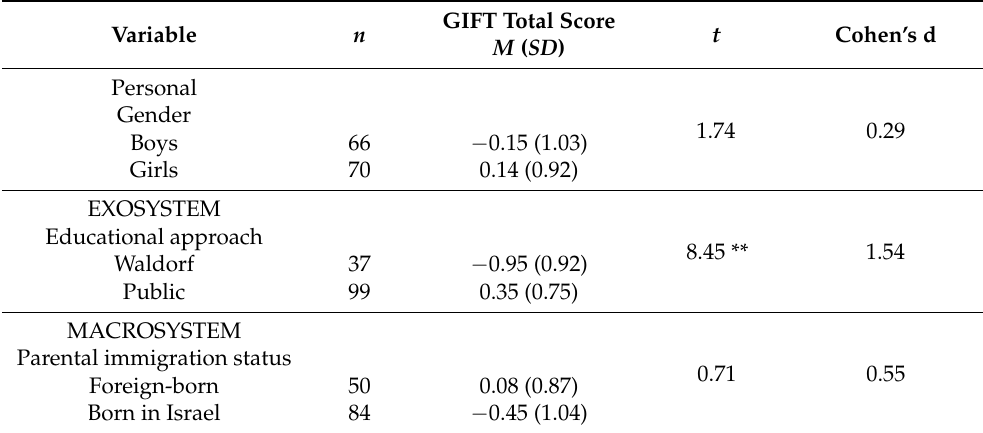
Table 3. Personal and environmental factors: differences in the performance of